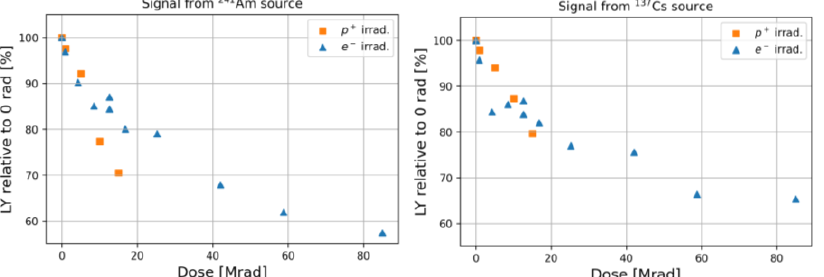
Figure 7. Irradiated PEN light yield normalized to that of a pristine scintillator as a function of the delivered dose for proton and electron irradiations. Scintillation light was measured upon excitation with ( left ) 241 Am and ( right ) 137 Cs sources.